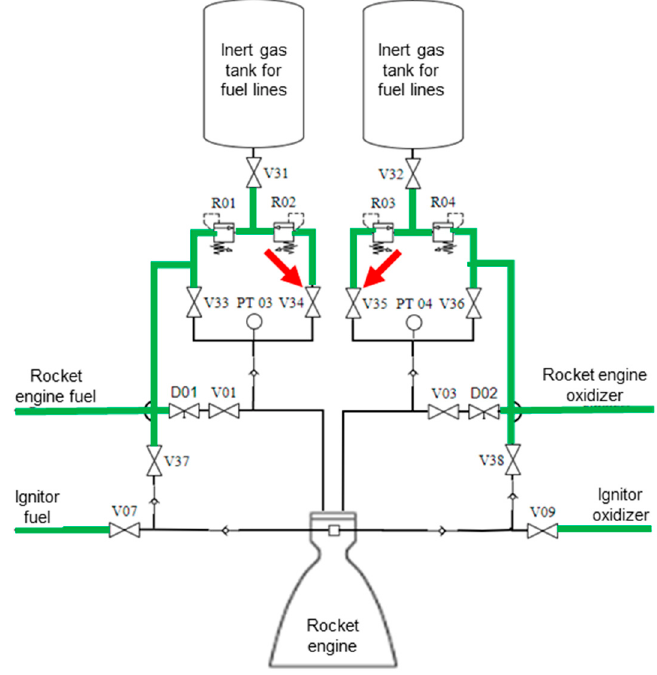
Figure 35. Algorithm’s 14th step diagram.